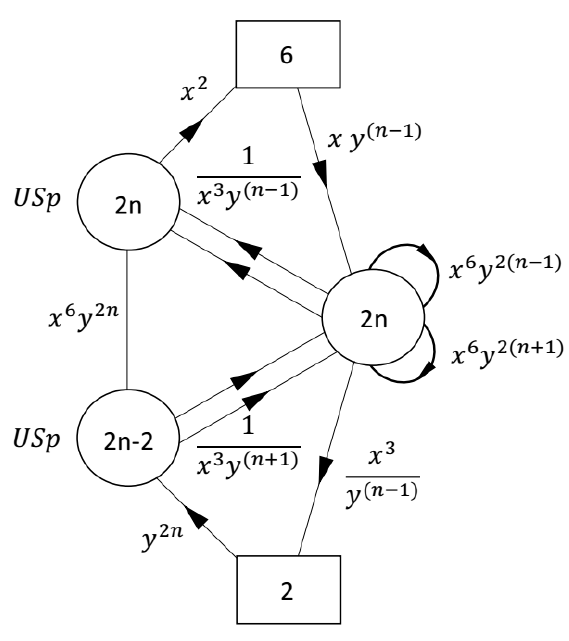
Figure 8 . The proposed 4 d quiver theory. There are cubic superpotentials along all triangles. As previously, we use arrows from the group to itself to denote antisymmetric chiral (cid:12)elds, where here one is in the antisymmetric representation, and the other in the conjugate antisymmetric representation. These two antisymmetric chirals are coupled to the appropriate bifundamentals via cubic